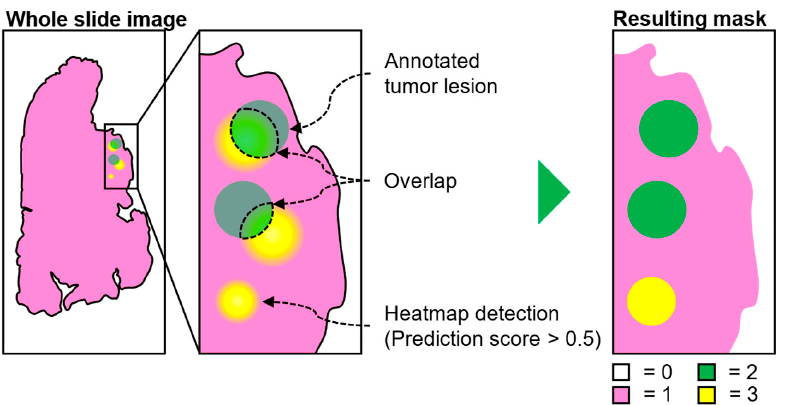
Figure 2. Hard negative mining protocol. Mask generation is based on model generated heatmap (yellow regions) and existing ground-truth annotations (green regions). Heatmap regions overlapping with the ground truth are excluded in the final mask where background (white) is coded as 0, healthy tissue (pink) as 1, ground-truth annotations as 2 (green), and hard negative regions as 3 (yellow).